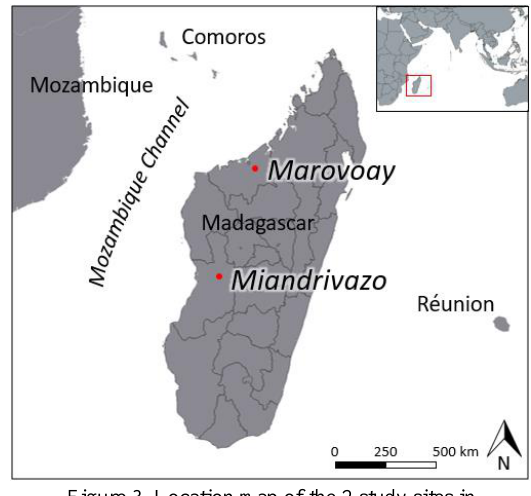
Figure 3. Location map of the 2 study sites in Madagascar, Miandrivazo and Marovoay.